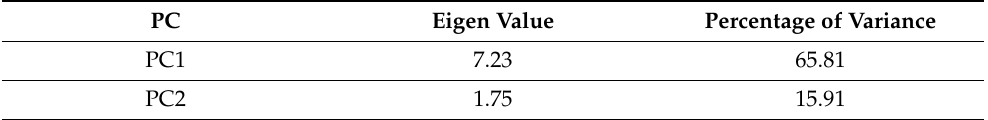
Table 4. Eigen values of percentage of variance of the principal components of area parameter.